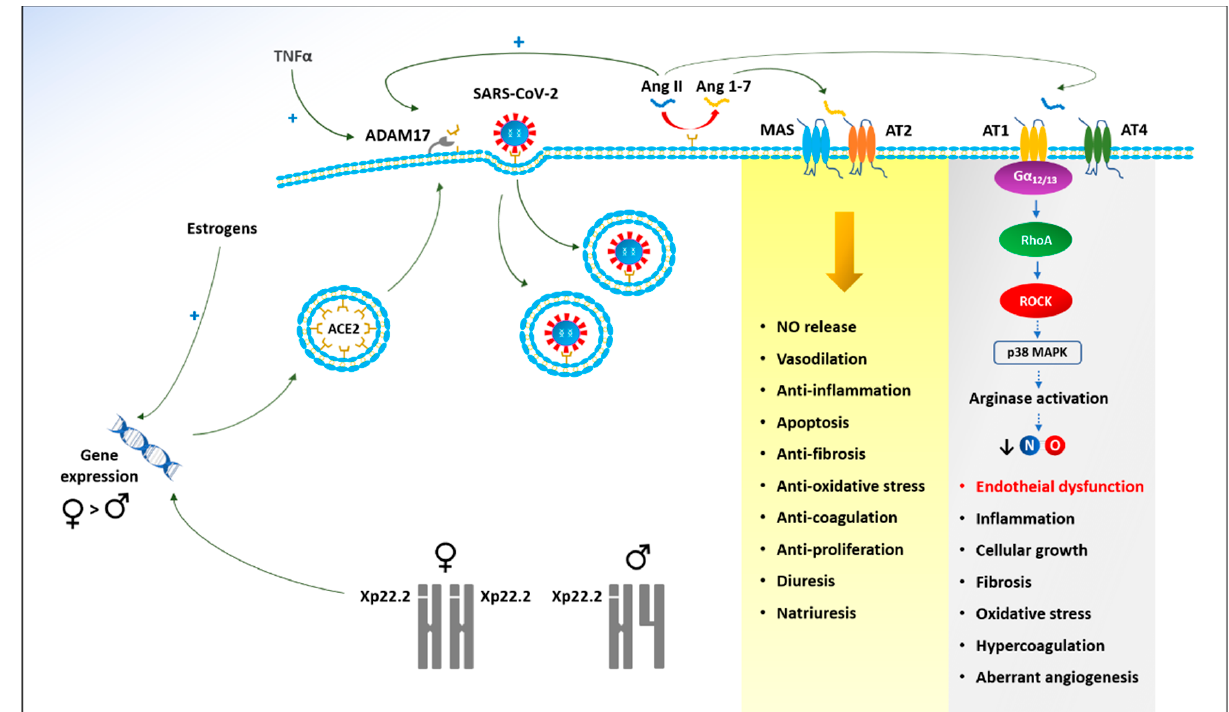
Figure 4. Physiopathology of endothelial dysfunction and gender differences in coronavirus disease 2019 (COVID-19). SARS-CoV-2: Severe acute respiratory syndrome coronavirus 2; TNF α : Tumor necrosis factor alfa; ADAM17: A disintegrin and metalloprotease 17; ACE2: Angiotensin converting enzyme 2; Ang II: Angiotensin II; Ang 1–7: Angiotensin 1–7 ; MAS: Proto-oncogene G-protein–coupled receptor; AT1: Angiotensin receptor type 1; AT2: Angiotensin receptor type 2; AT4: Angiotensin receptor type 4; G α 12/13 : Guanine nucleotide-binding protein alpha 12/13; RhoA: Ras homolog family member A; ROCK: Rho-associated protein kinase; p38 MAPK: p38 mitogen-activated protein kinase; NO: Nitric oxide.